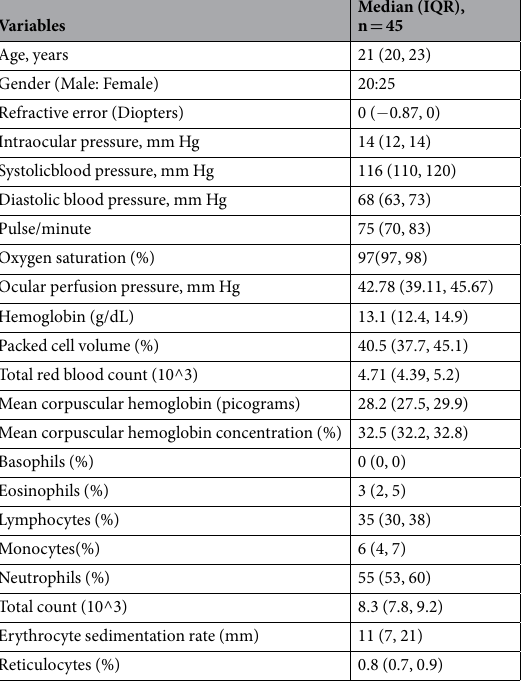
Table 1. Demographic, Ocular, and Systemic Parameters of the Study Population. IQR,interquartile range; mm Hg, millimeter of mercury.